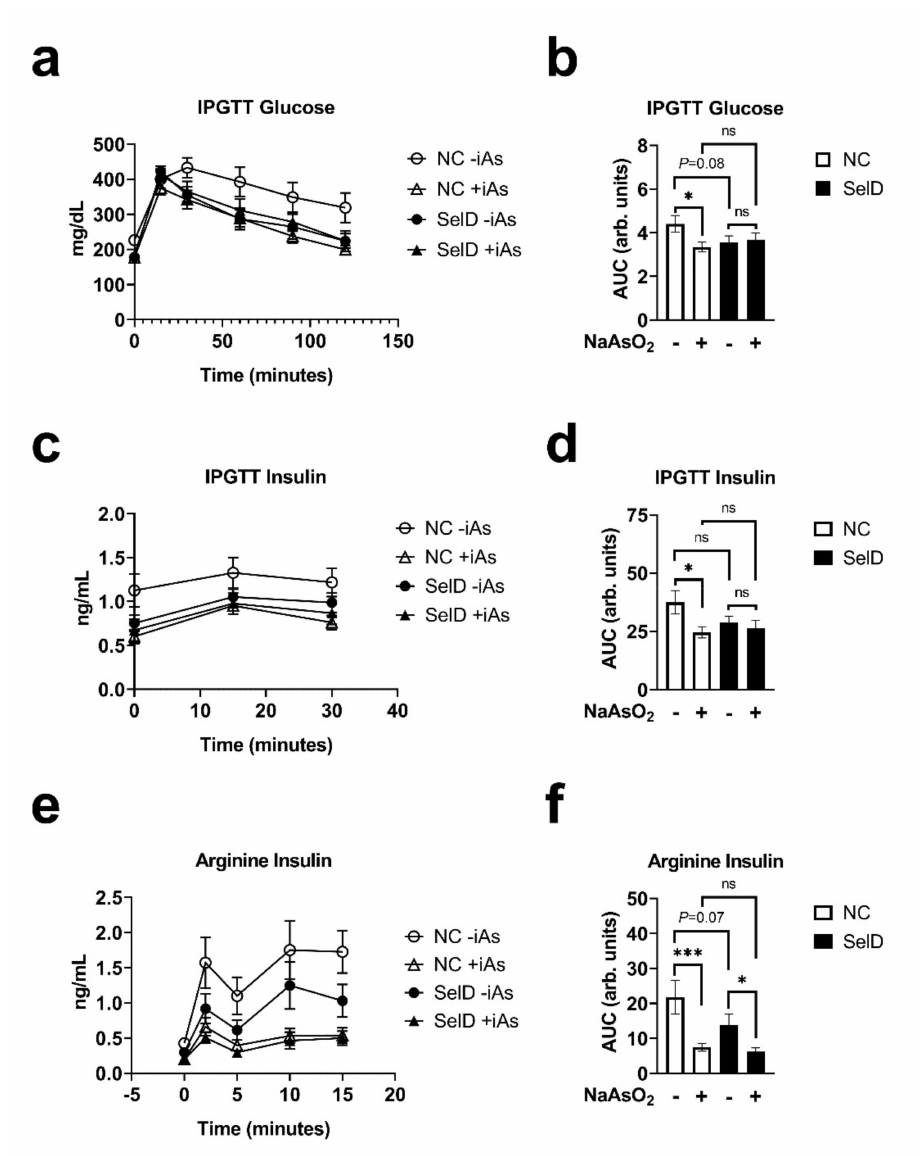
Figure 2. Effects of arsenic exposure and/or selenium status on dynamic metabolic parameters. ( a ) Blood glucose measured during an intraperitoneal glucose tolerance test (IPGTT) ( n = 10–14); ( b ) area under the curve (AUC) of blood glucose values measured during IPGTT ( n = 10–14); ( c ) plasma insulin during IPGTT ( n = 10–14); ( d ) AUC of plasma insulin values measured during IPGTT ( n = 10–14); ( e ) plasma insulin during arginine stimulation test ( n = 10–11); ( f ) AUC of plasma insulin values measured during the arginine stimulation test ( n = 10–11). Data were combined from three independent experiments. Statistics: All data were log-transformed for statistical analysis. ( a , c , e ) Mixed-model ANOVA was used to test overall differences in body mass between groups; ( b , d , f ) ANCOVA was performed testing for main effects and interactions. * p < 0.05, *** p < 0.001, ns = not